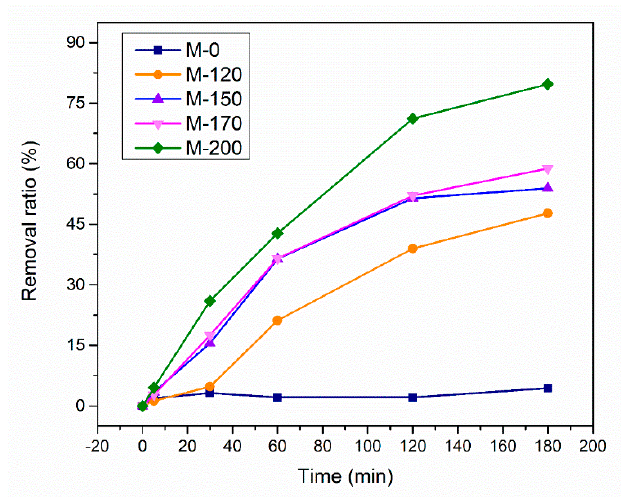
Figure 5. Catalytic performance of all samples (subtract the value of adsorption). Experimental conditions: (X-3B) = 100 mg L − 1 , (PS) = 15 mmol L − 1 , catalyst dosage = 0.1 g L − 1 , T = 25 °C.